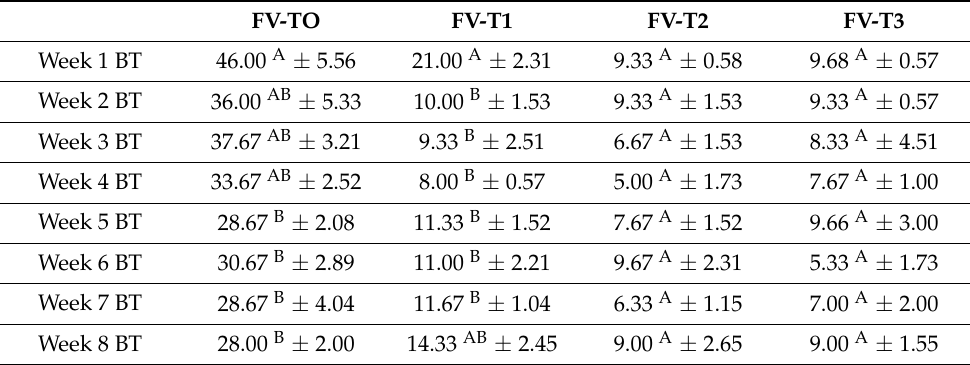
Table 5. Survival (V) of Parlatoria ziziphi females treated with different doses of spirotetramat (T0 = 0 L/ha, T1 = 0.625 L/ha, T2 = 0.755 L/ha, and T3 = 1 L/ha) according to different follow-up dates after treatment.